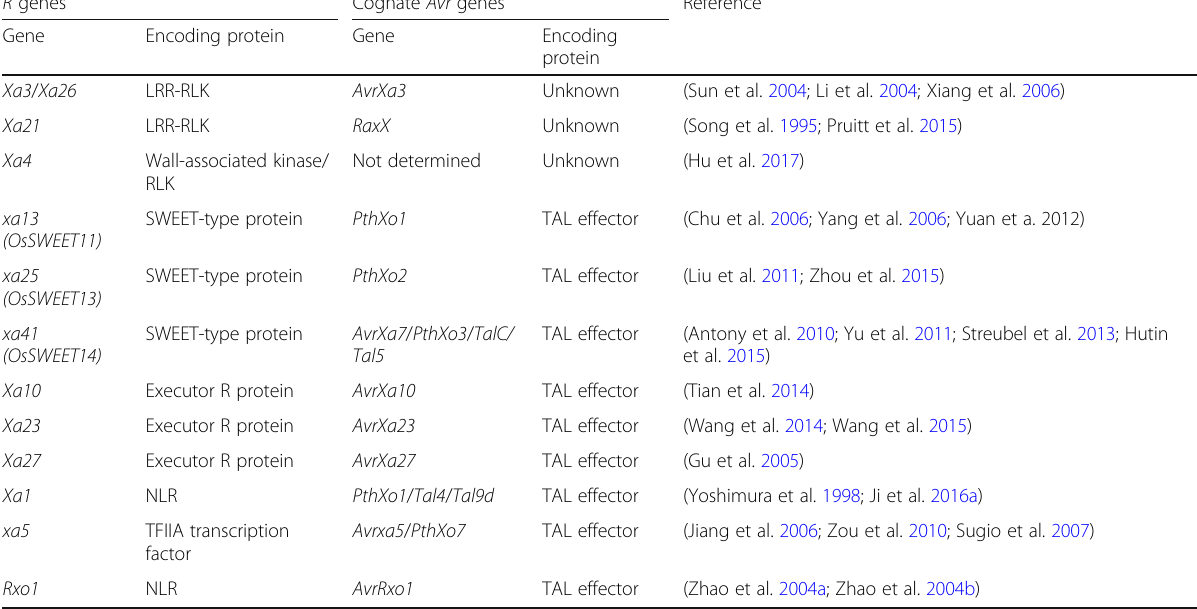
Table 1 Summary of the cloned rice R genes and the cognate Xanthomonas oryzae Avr genes R